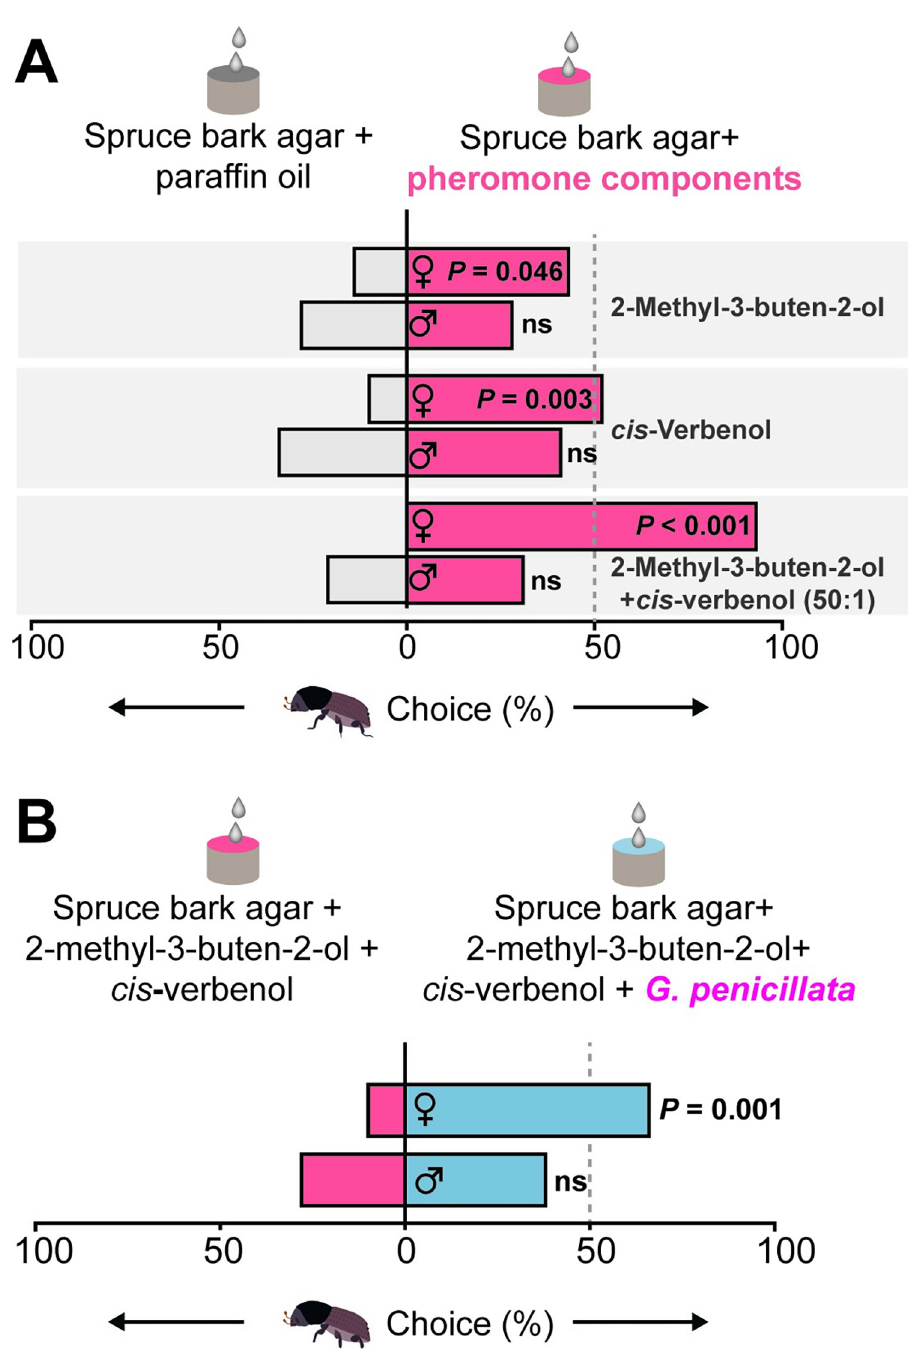
Fig 7. Female adult I . typographus are attracted towards a pheromone mixture in the presence of G . penicillata volatiles. (A) Adult females chose traps containing 2-methyl-3-buten-2-ol and cis -verbenol at 10 − 2 concentration diluted in mineral oil over control traps containing mineral oil. Females strongly preferred traps containing a binary pheromone blend ( cis -verbenol: 2-methyl-3-buten-2-ol, 50:1) diluted in mineral oil over the mineral oil control (bottom). Adult males were unresponsive to these concentrations of individual pheromones and their blend. (B) Adult females preferred pheromone blend in the presence of G . penicillata volatiles over pheromone blend without fungus. (A, B) . Deviation of response indices against zero was tested using Wilcoxon’s test ( n = 28 for each experiment). The data underlying this Figure can be found at https://doi.org/10.6084/m9.figshare.21692156.v1.